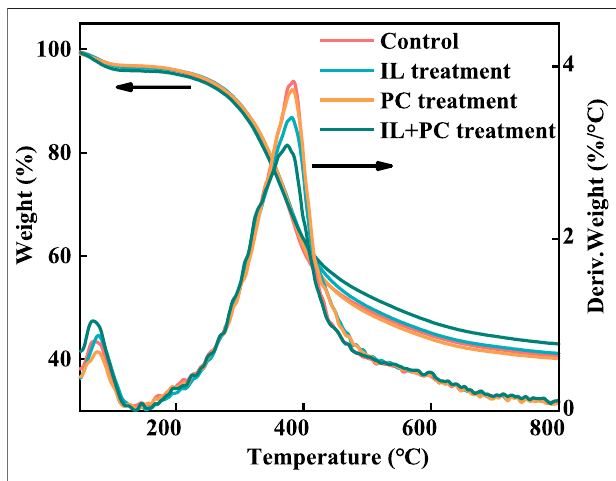
FIGURE 5 | DTG and TG analyses of alkali lignin before and after fungi treatment.